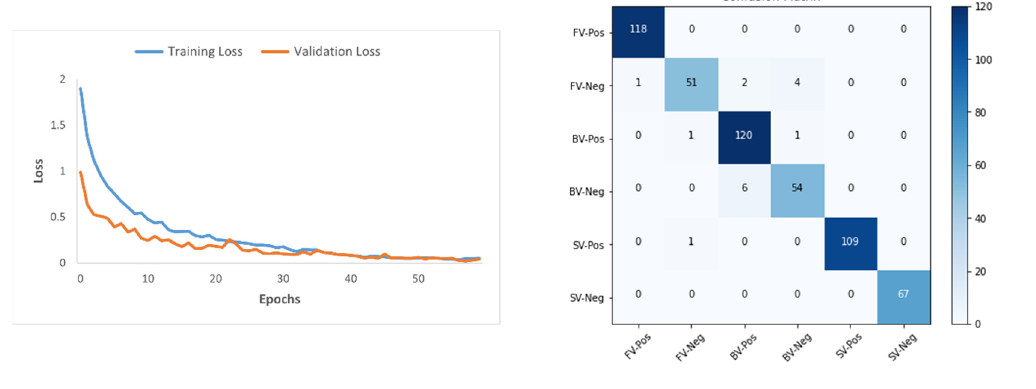
Figure 10. The loss curve and confusion matrix of the first experiment on the PETA dataset: ( a ) The loss curve, ( b ) the confusion matrix.